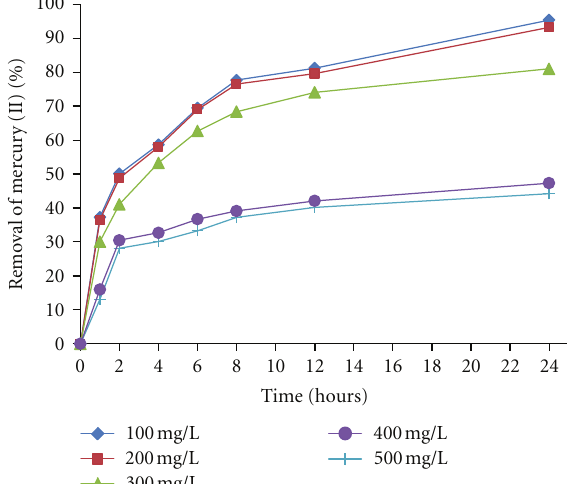
Figure 3: The e ff ect of the concentration of mercury (II) in solution on the removal of Hg (II) ions. 100 rpm, 30 ◦ C, pH 5.5.1 g of fungal biomass of M. rouxii IM-80.